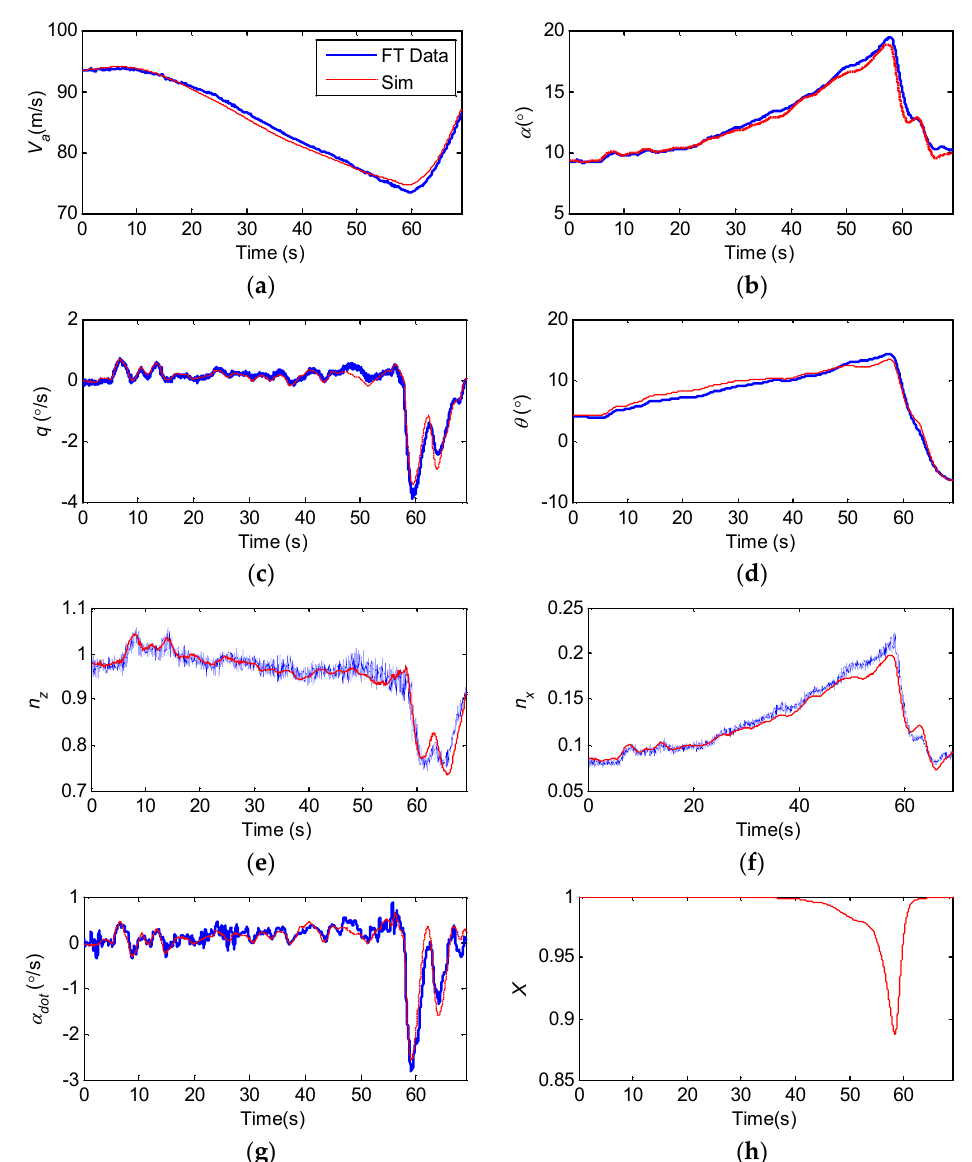
Figure A1. Model predictive capability validation. ( a ) Airspeed; ( b ) Angle of attack; ( c ) Pitch angular velocity; ( d ) Pitch angle; ( e ) z−axis overload; ( f ) x−axis overload; ( g ) Change rate of AOA; ( h ) Change of X .